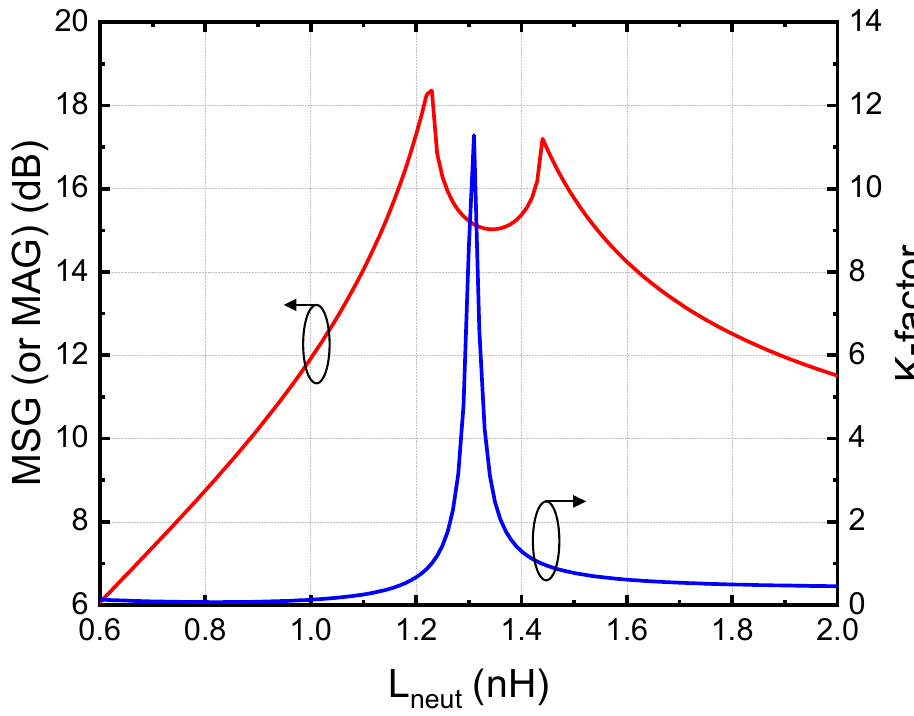
Figure 3. Simulated MSG (or MAG) and stability factor K at 39 GHz versus L neut .